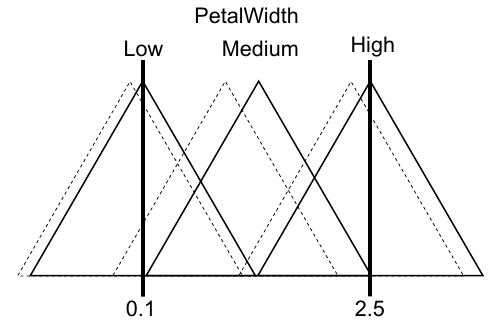
Fig. 3. Initial and lateral tuning for the variable PetalWidth in the iris data